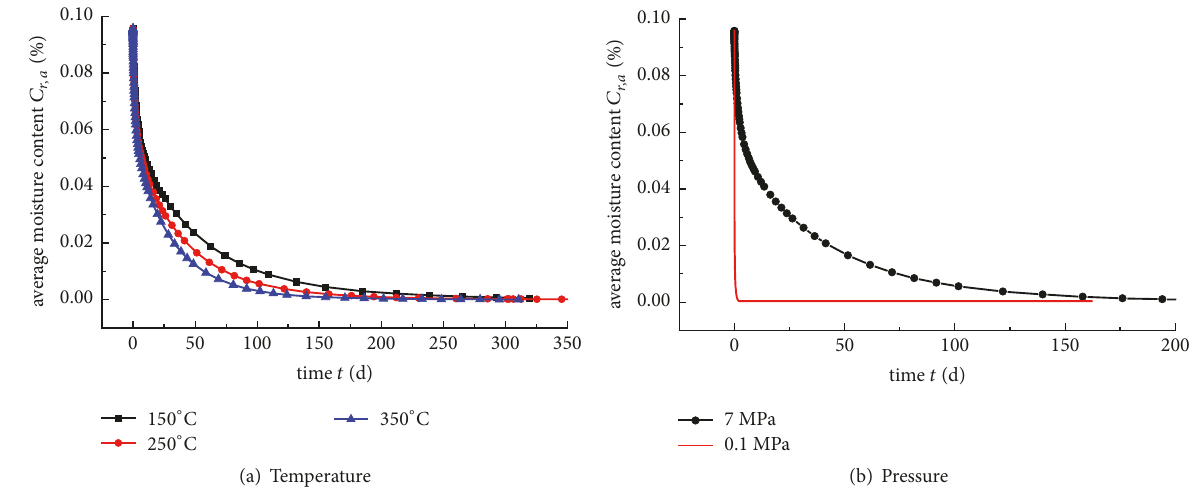
Figure 5: Curves of moisture versus time at different temperature and pressure.